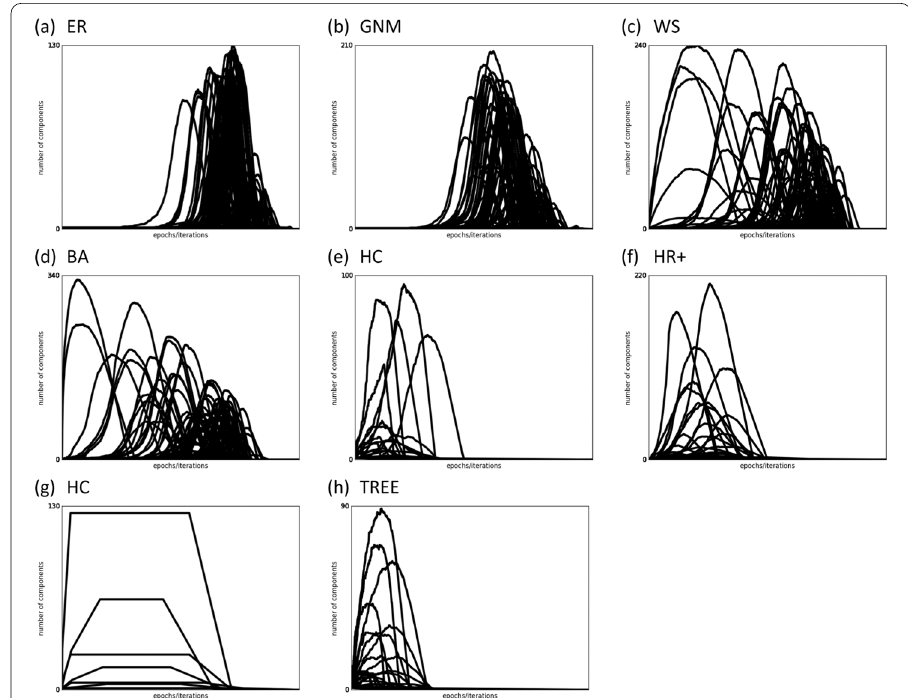
Fig. 7 The response of the eight graph models to the degree based node selection failure model method. Each response is plotted with the y-axis showing the number of components and the x-axis showing the % of nodes removed from the graph, and thus the most robust graphs would show a small number of components, with any increase shown to the right of plots as x tends away from 0. Plots ( a )–( d ) show clear increase in the number of components to the right of the plots suggesting a robust response, with a small number of exceptions in ( c ) and ( d ) where the targeted analysis results in a small number of 1000 graphs failing much more quickly. The other four plots ( e ), ( f ) and ( h ), show peaks much closer to the left of the plots, suggesting a less robust response, and plot ( g ) shows a unique response pattern, suggesting a greater robustness than in ( a )–( d ), but more than shown in ( e ), ( f ) and ( h